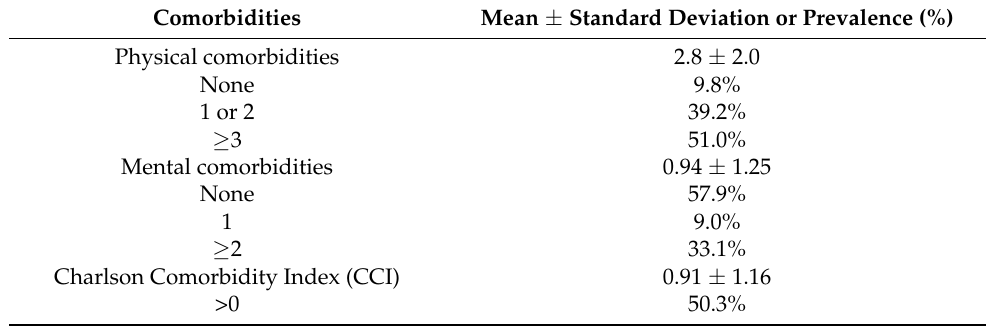
Table 3. Burden of comorbidities in SLE patients at the community-based registry in